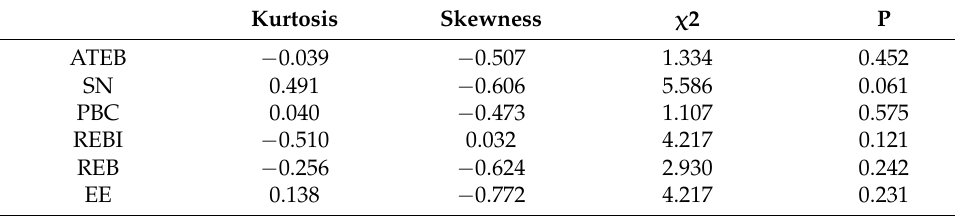
Table 7. Analysis results of normality test.